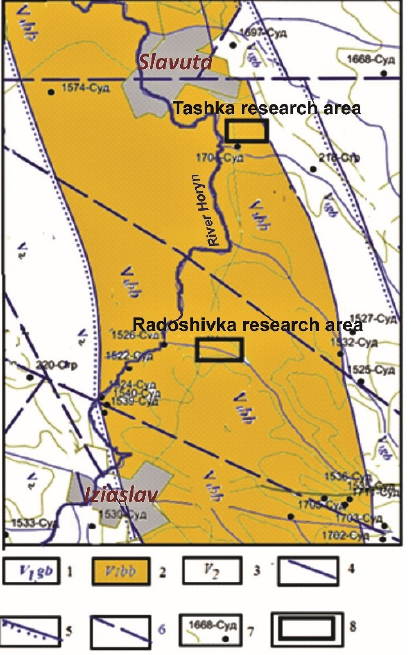
Figure 2. Location of the tuff stratum of the Lower Vendian in the Slavutych and Izyasldav districts of the Khmelnytskyi region: 1—strata of the Lower Vendian (Gorbashiv Formation); 2—strata of the Lower Vendian (Babin Formation); 3—strata of the Upper Vendian; 4—boundaries of strata with agreed occurrence; 5—boundaries of strata with uncoordinated occurrence; 6—probable rupture violations; 7—opened wells of the Domezozoic formations; 8—areas of detailed geological exploration of saponite tuffs in Tashka (top frame) and in Radoshivka (bottom